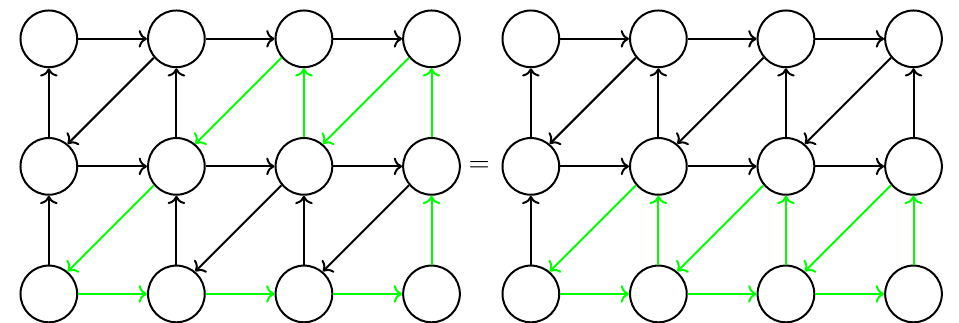
Figure 9. Visualisation for the example of p = 3 . On the left Q Φ Φ reduced to Q 2 Q Q Q ( i − 1 ,n +3) e ( i − 1 ,n +2) ( i − 1 ,n +2) e ( i − 1 ,n +1) e ( i,n ) Again further applying the F-terms means this operator can be completely written in terms of M